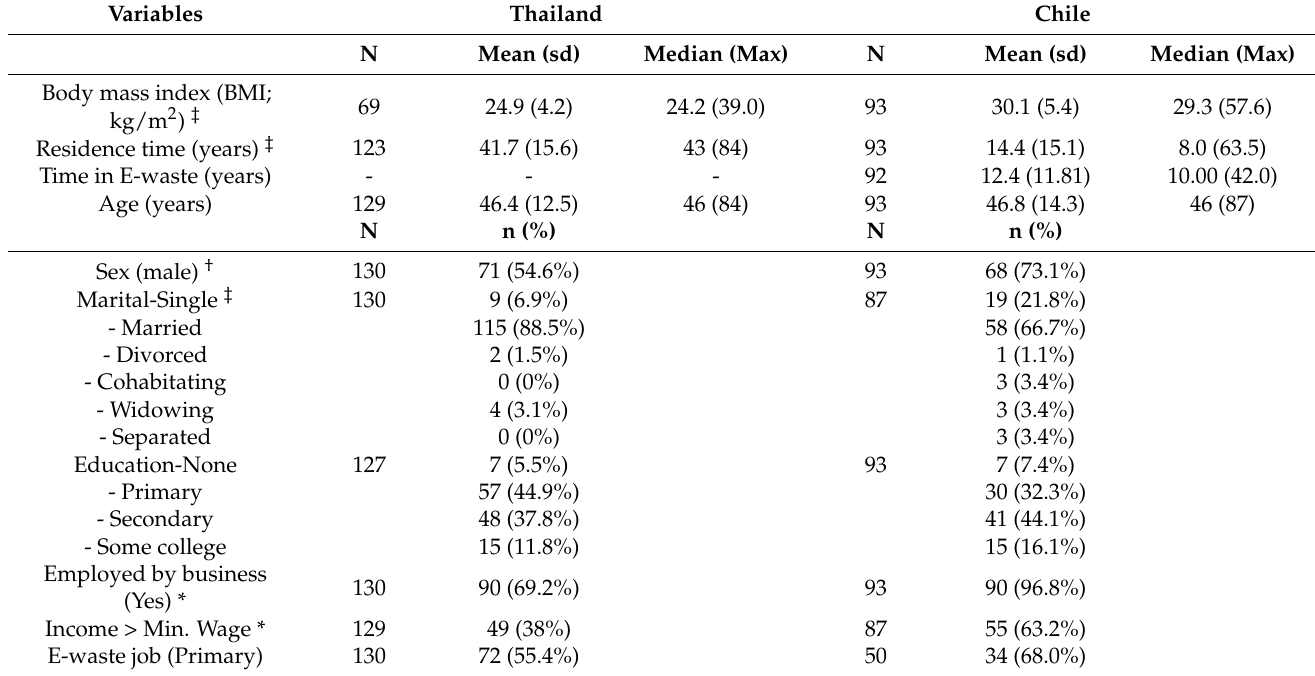
Table 1. Demographic characteristics of Thai and Chilean e-waste recycling workers.